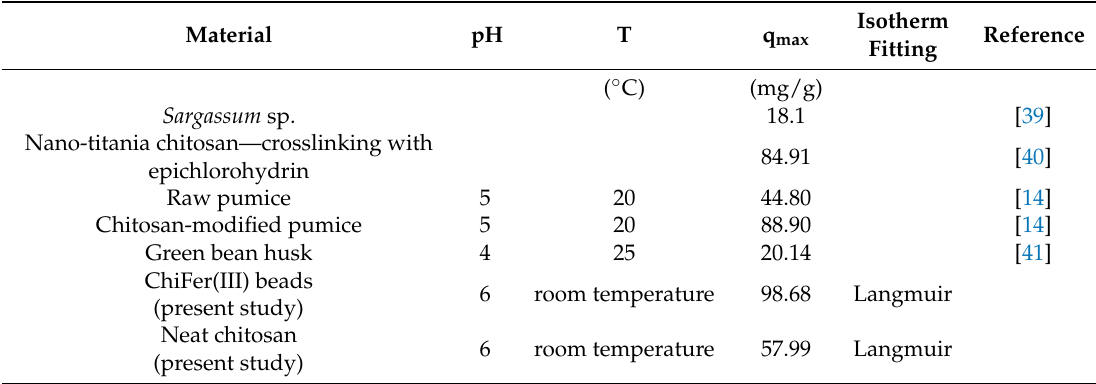
Table 1. Adsorption capacity of Sb(III) with different biomaterials.